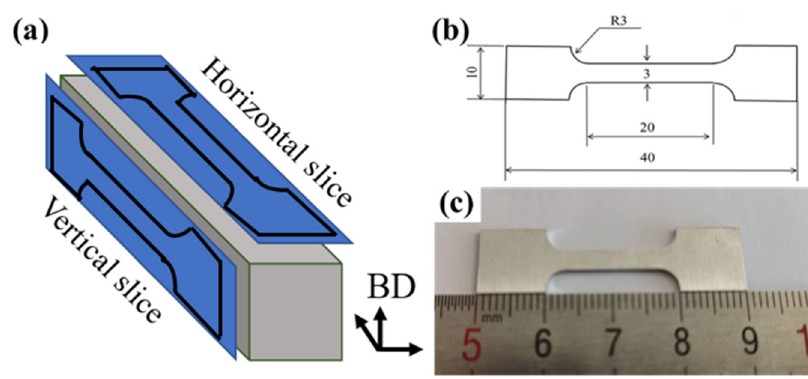
Figure 2. Diagram of tensile plate ( a ) horizontal sample, building direction (BD) and sampling di- rection, ( b ) schematic diagram (mm) and ( c ) real sample. direction, ( b ) schematic diagram (mm) and ( c ) real